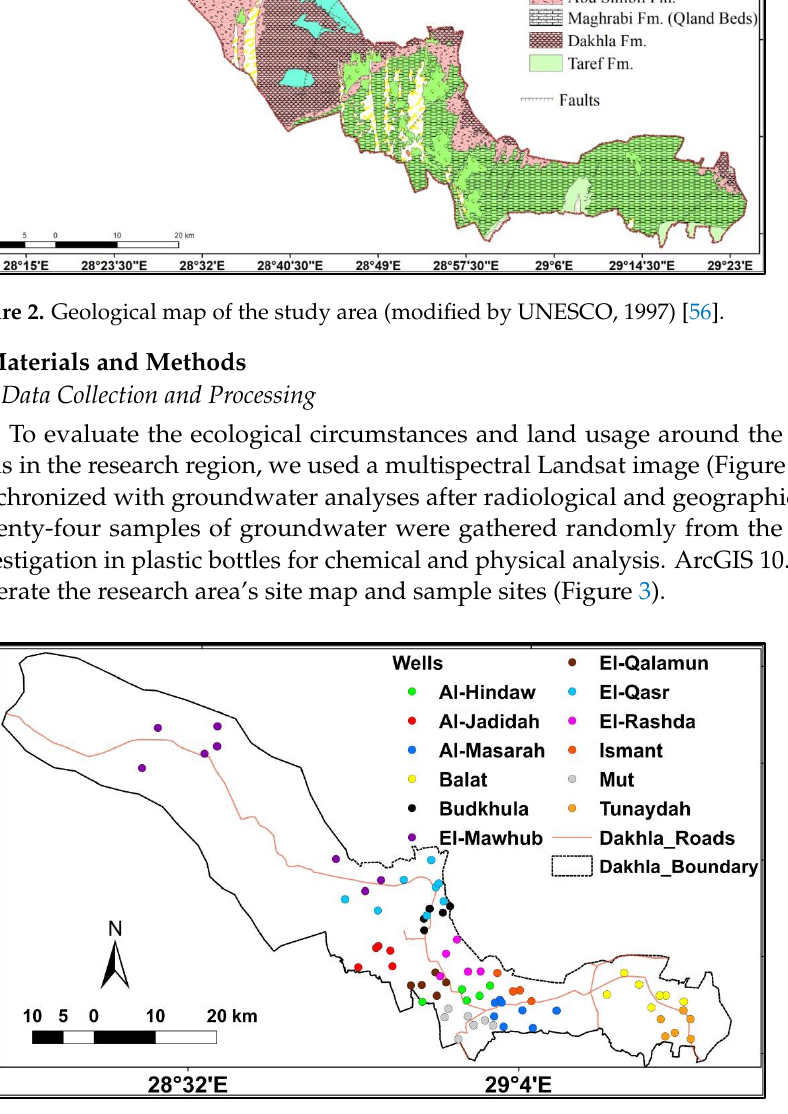
Figure 3. Location map of monitoring points of groundwater samples in the study area.